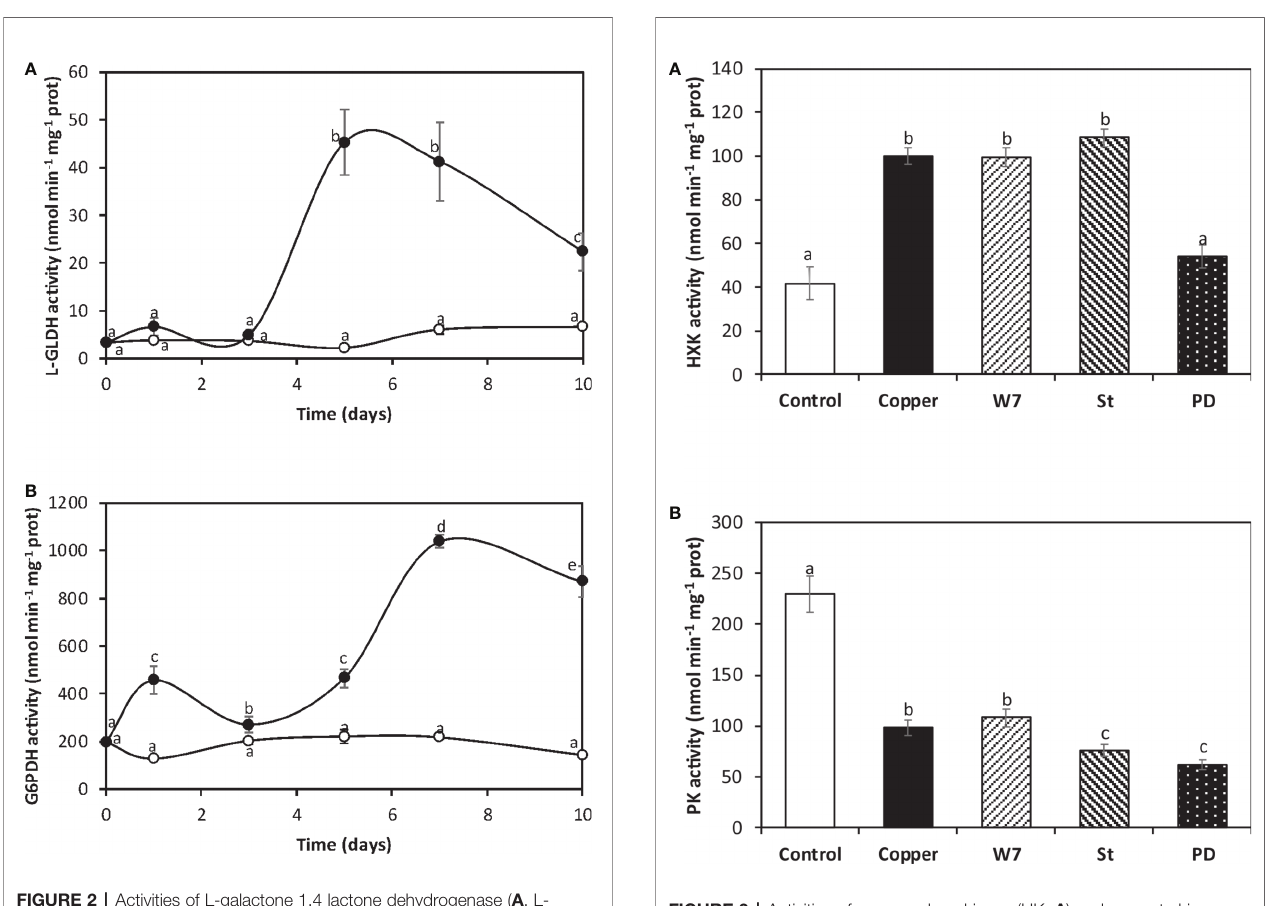
FIGURE 3 | Activities of enzymes hexokinase (HK, A ) and pyruvate kinase (PK, B ) cultivated in seawater without copper addition for 5 days (open bars) and with 10 µM of copper and with 100 µM of W-7 and 10 µM copper, 10 µM staurosporine (St) and 10 µM copper, and with 5 µM of PD-98059 (PD) and 10 µM copper for 5 days. Enzyme activities are expressed in nanomoles per minute per milligram of protein extract. Bars represent mean values of three independent experimets. Different letters indicate signi fi cant diferences among mean values (±SD) ( P <